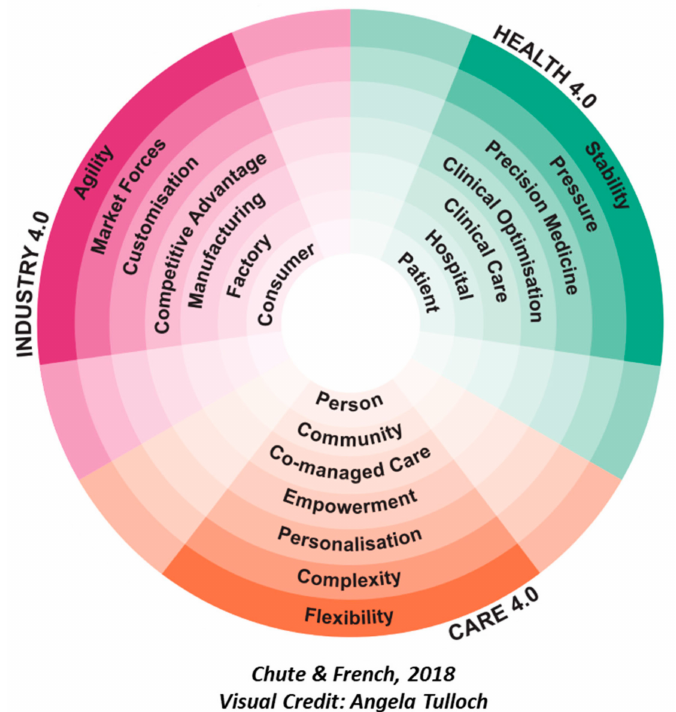
Figure 3. Industry 4.0 applied to new, integrated health, and social care services (Care